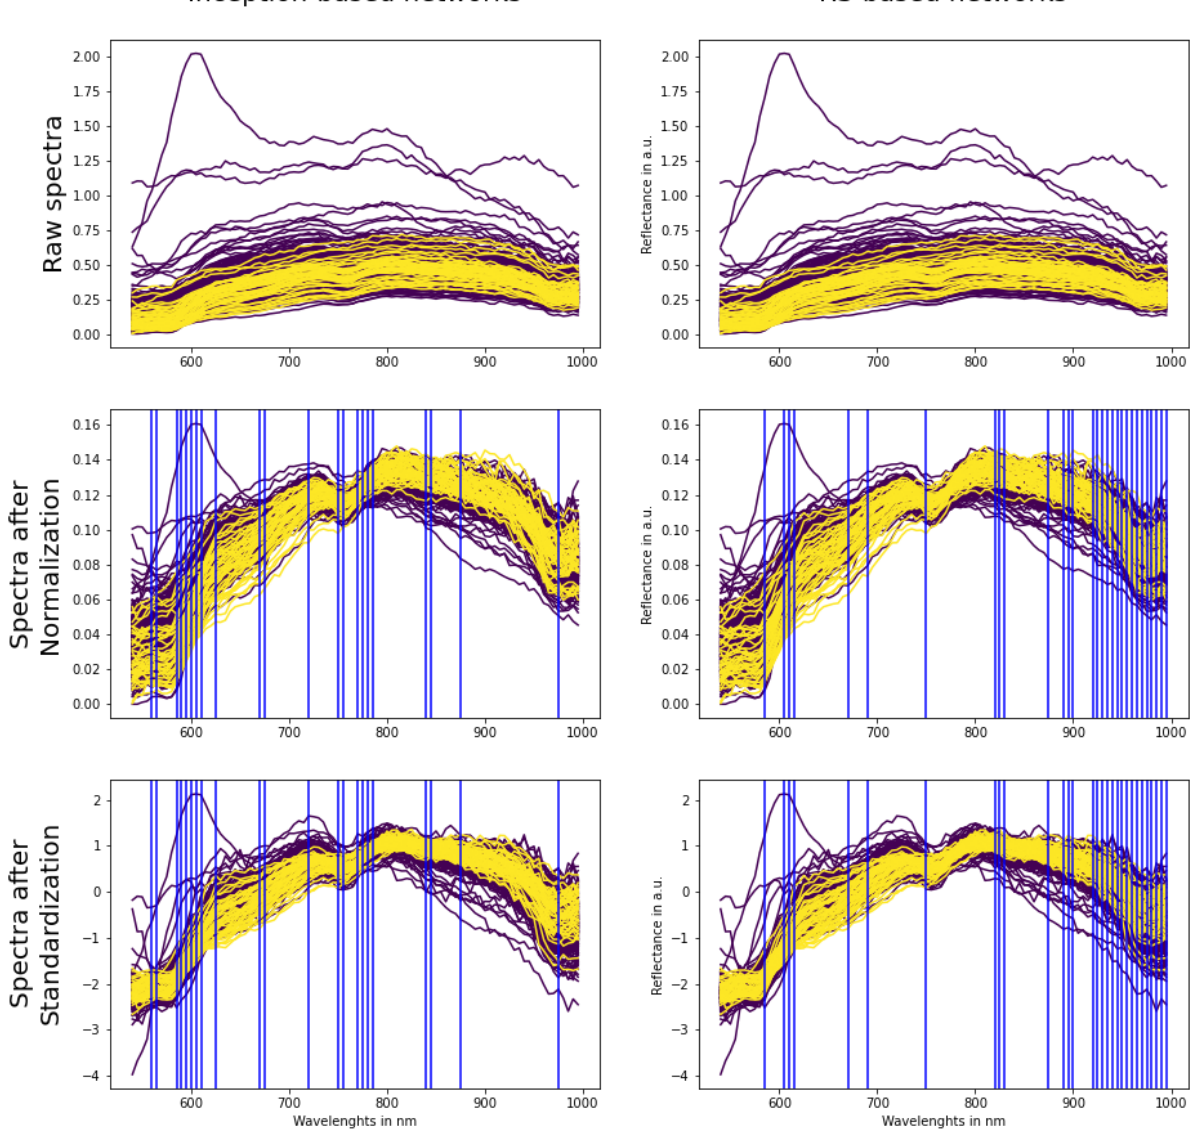
Figure 10. Blue lines specify the most important wavelengths (key wavelengths) for inception-based models ( left column ) and RS-based models ( right ). Spectrum of non-malignant tissues is plotted with purple color, cancerous with yellow. Please note that y axes have different scales.